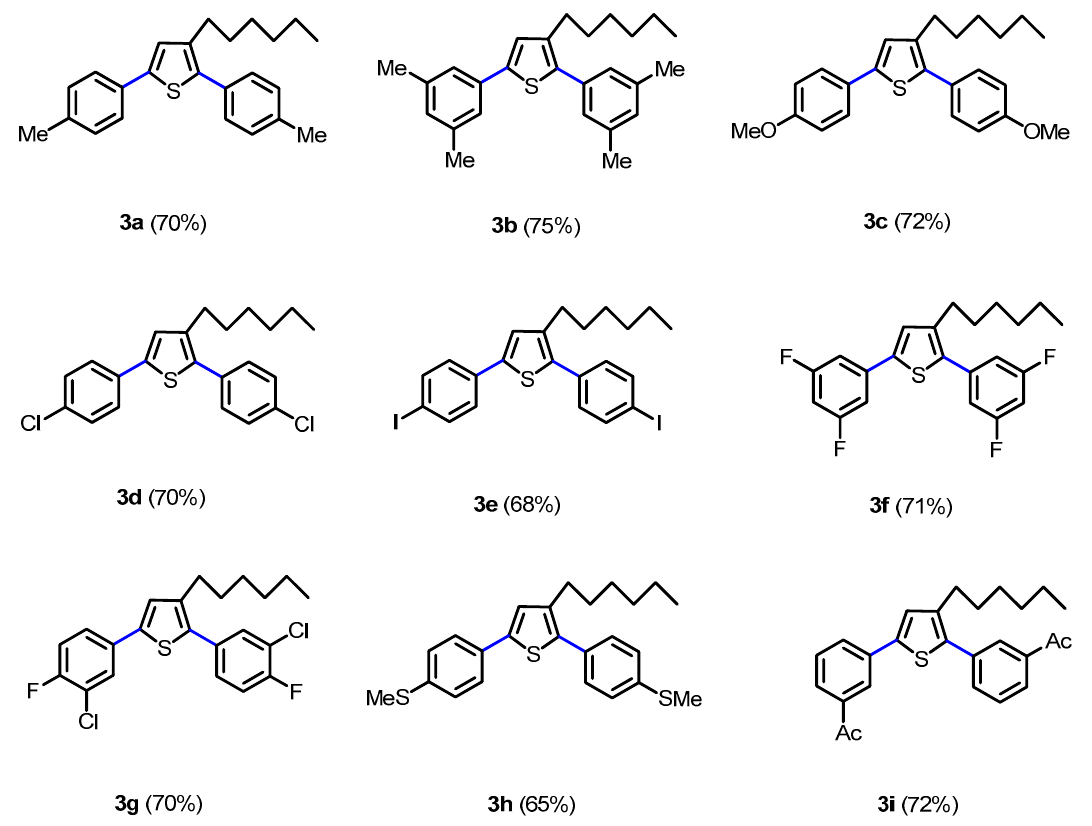
Figure 1. Synthesis of 2,5-biaryl-3-hexylthiophene derivatives ( 3a – i ).